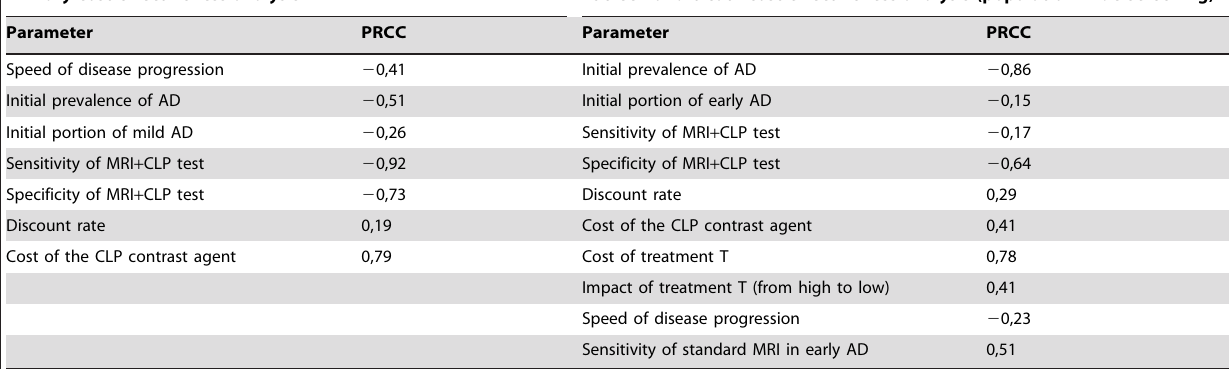
Table 3. Partial rank correlation coefficients (PRCC) between input values and the ICER of the MRI + CLP strategy (compared with the preferred strategy).